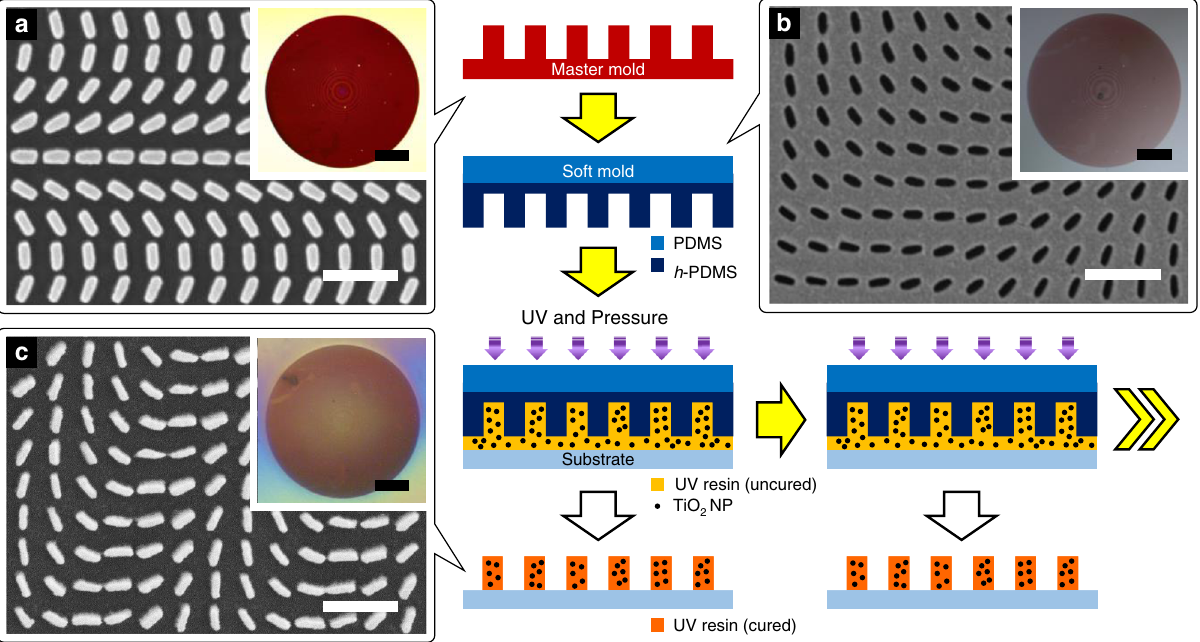
Fig. 3 Fabrication schematic of plum pudding metalens. A master mold is fabricated by electron beam lithography and coated by the self-assembled monolayer (SAM) to improve mold release. Hard polydimethylsiloxane ( h -PDMS) is coated on the master mold, then a polydimethylsiloxane (PDMS) buffer layer is spread on the h -PDMS layer. A released soft-mold is also coated by the SAM to facilitate mold release in succeeding processes. Nanoparticle composite (NPC) which consists of titanium dioxide (TiO 2 ) nanoparticles (NPs) in a matrix of UV-curable resin is dropped on a glass substrate, and then it is covered by the soft-mold. UV light illumination with appropriate pressure hardens the NPC in the form of the master mold. The replication process is completed by releasing the reusable soft-mold from the substrate, and the soft-mold is reusable for additional replication. The fi nal NPC patterns have a residual layer, but it is negligible because structures are much higher than the residual layer. a – c Scanning electron micrographs of the master mold, soft mold, and fi nal plum pudding metalens, respectively. All scale bars: 1 μ m. (insets) Optical micrographs of each. All scale bars: 100 μ